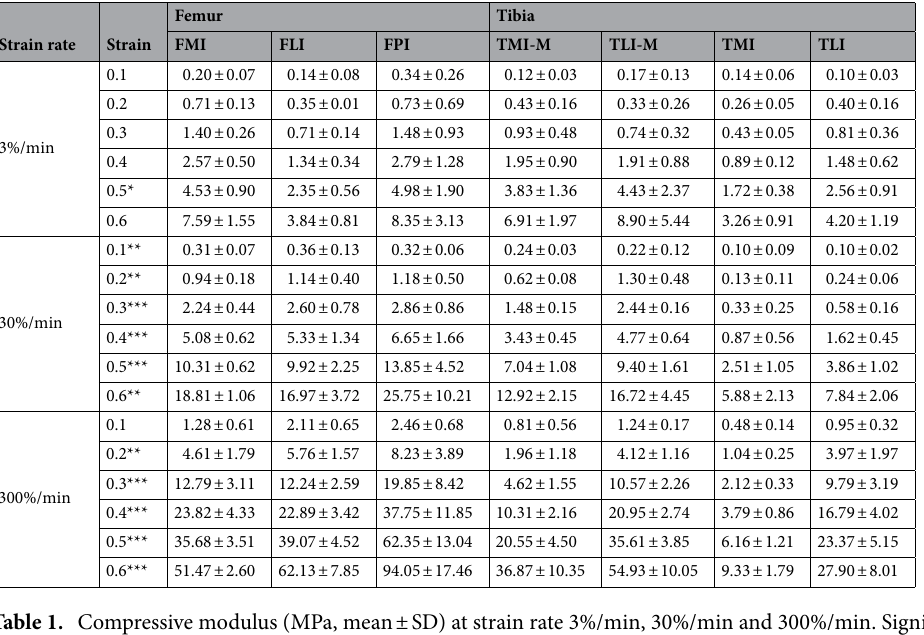
Table 1. Compressive modulus (MPa, mean ± SD) at strain rate 3%/min, 30%/min and 300%/min. Significant different between different cartilage regions: * p < 0.05, ** p < 0.01, *** p < 0.001.